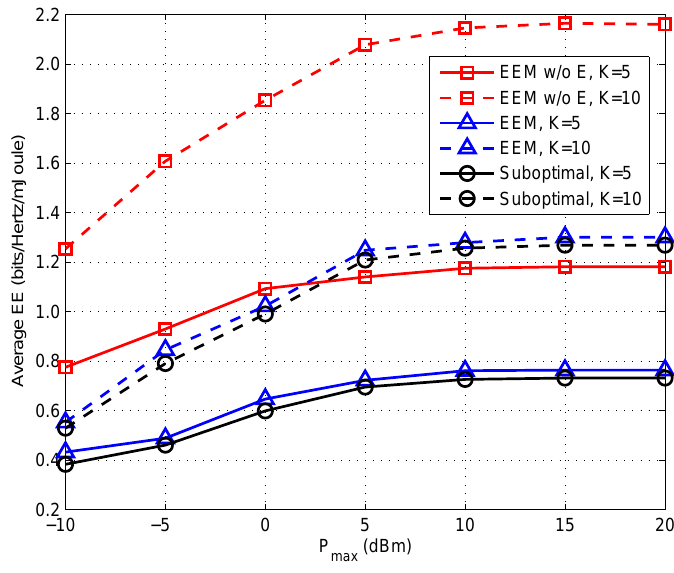
Figure 3. Average EE versus different P max